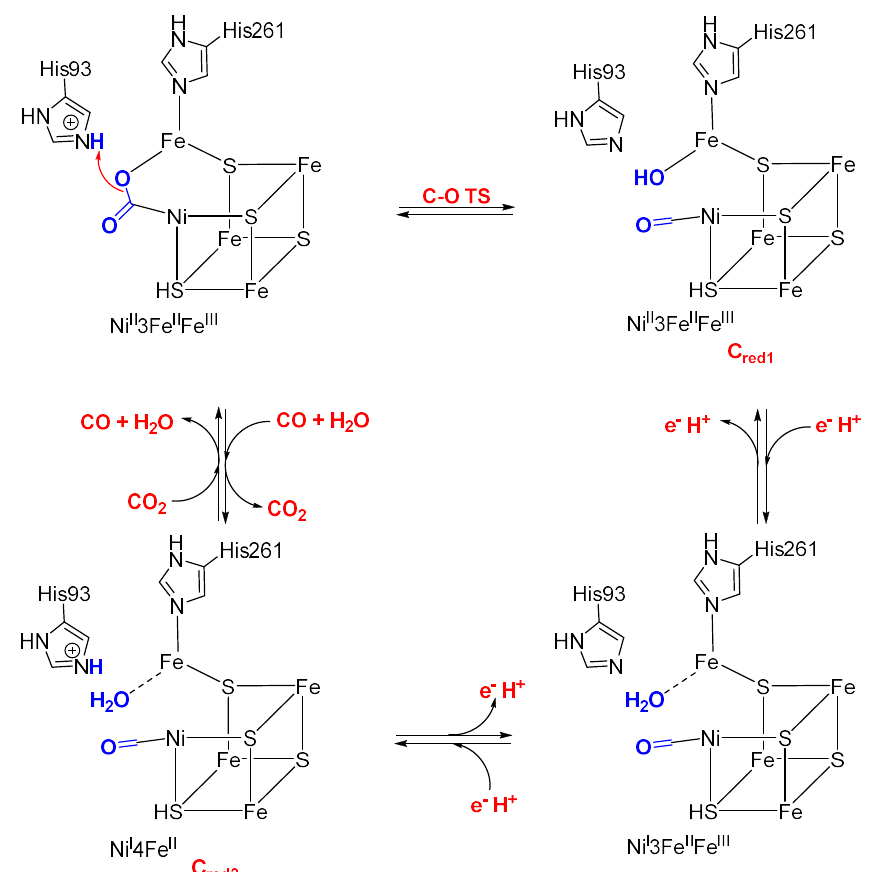
Figure 8. Mechanism of nickel CO dehydrogenase suggested on the basis of density functional calculations. Adapted from [97], Copyright © 2019, American Chemical Society.